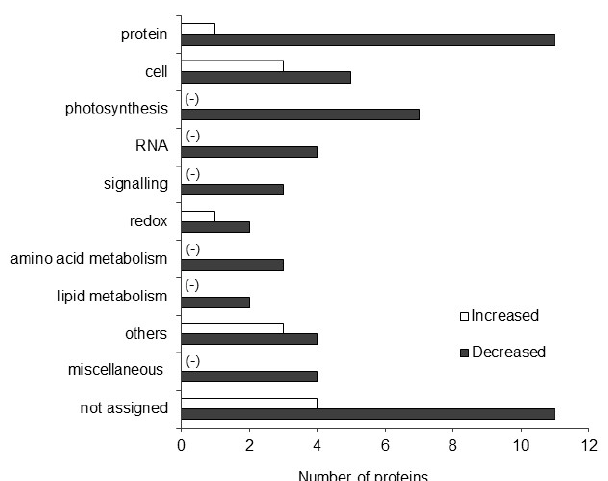
Figure 4. Categorization of identified proteins on the basis of their function in maize shoot in response to plant derived smoke solution. Maize seeds were treated without or with 2000 ppm plant-derived smoke solution for 6 h and grown for 4 days. Proteins were extracted from shoot and identified using a gel-free/label-free proteomic technique. Mapman bin code software was used to categories all the identified 69 proteins. Categories containing zero proteins are marked with ( − ). Abbreviations: protein, protein synthesis/degradation/ post-translational modification/targeting/folding; cell, cell division/organization/vesicle transport; RNA, RNA processing/ transcription/binding; Redox, redox homeostasis; The “Others” category includes proteins related to N-metabolism, cellular homeostasis, response to stimulus, cytoplasm, fermentation, DNA, nucleotide binding, and metal ion binding.